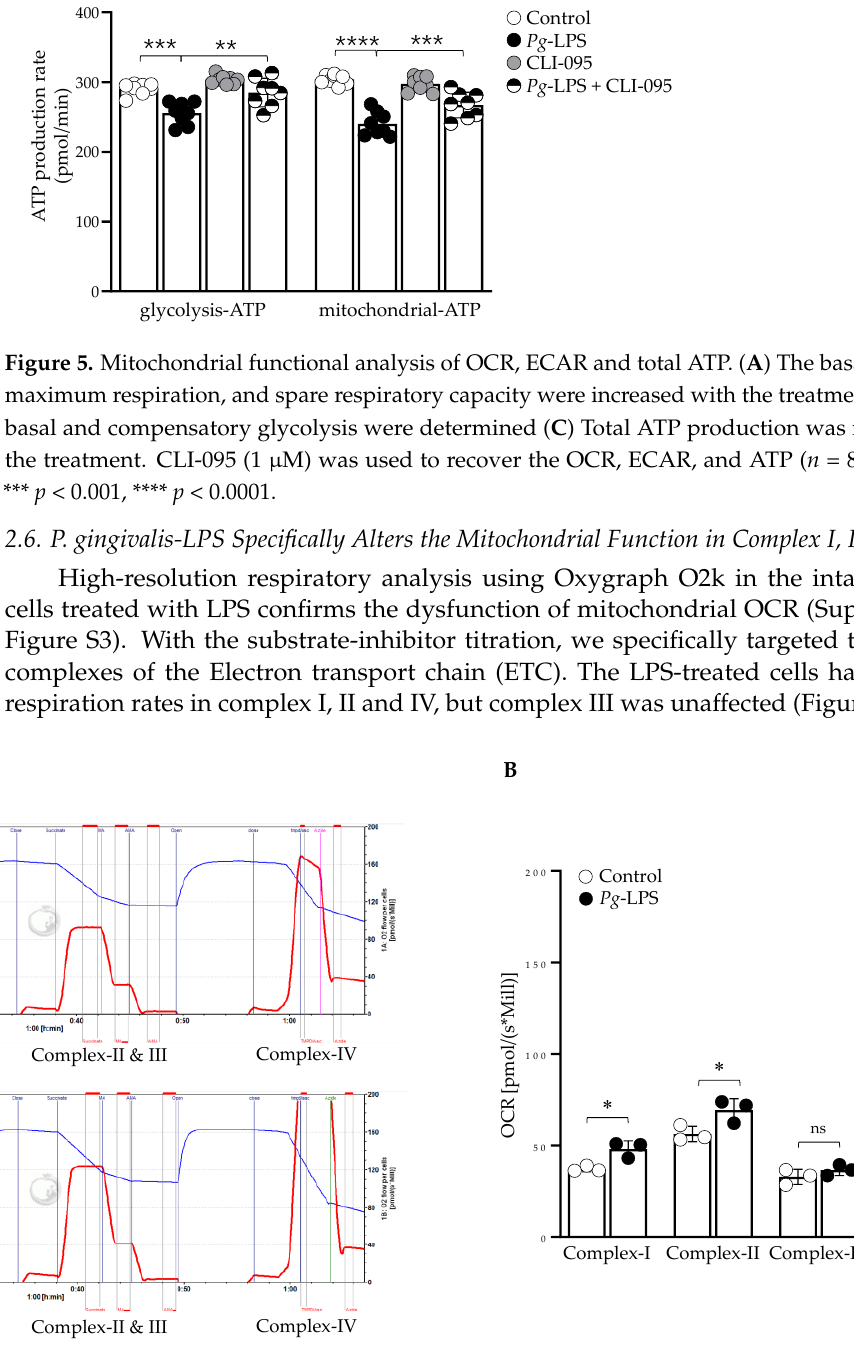
Figure 6. High-resolution respiratory analysis. ( A , B ) LPS at 10.0 µg/mL for 24 h was used for the treatment. Cells were permeabilized with digitonin and utilized to determine the OCR level at complexes of ETC ( n = 3). * p < 0.05, ns: p > 0.05.